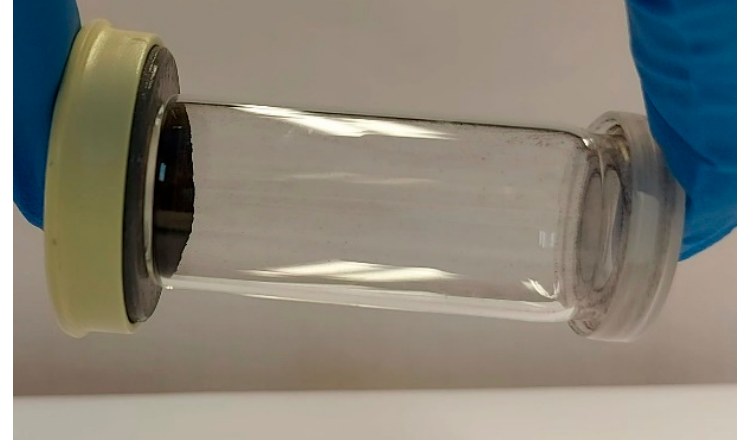
Figure 16. Presence of magnetic properties in the fresh catalyst Pd/8%Fe/Nb 2 O 5.